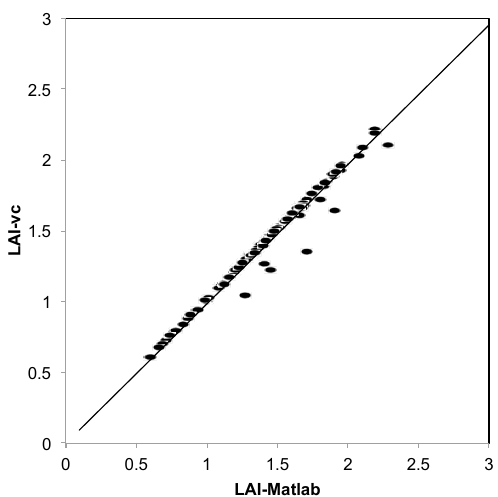
Figure 3. Relationship between the canopy size measured by analyzing the images using the Matlab method (LAI-Matlab) and VitiCanopy (LAI-vc). The continuous line represents the linear fitting; the dashed line represents the 1:1 relationship.